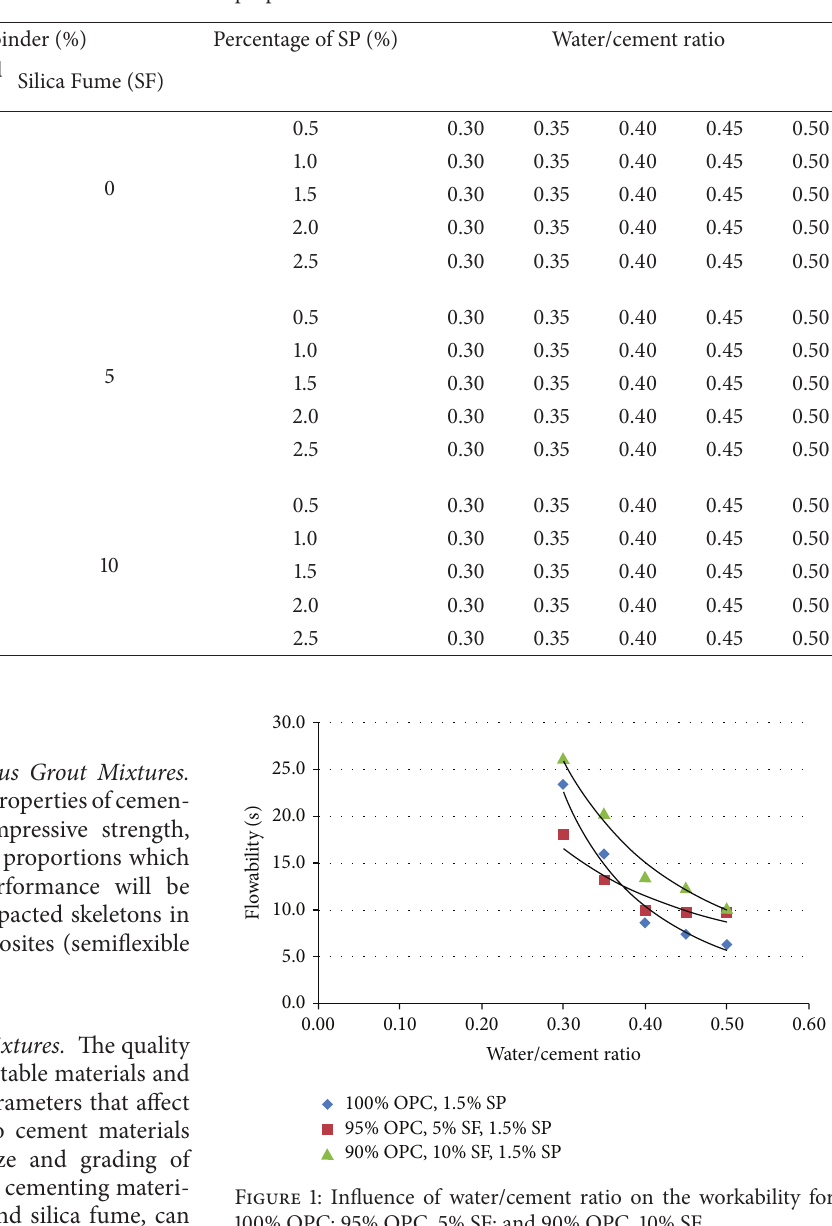
water/cement ratio is, the lower the viscosity is, because the flow time is inversely proportional to the water